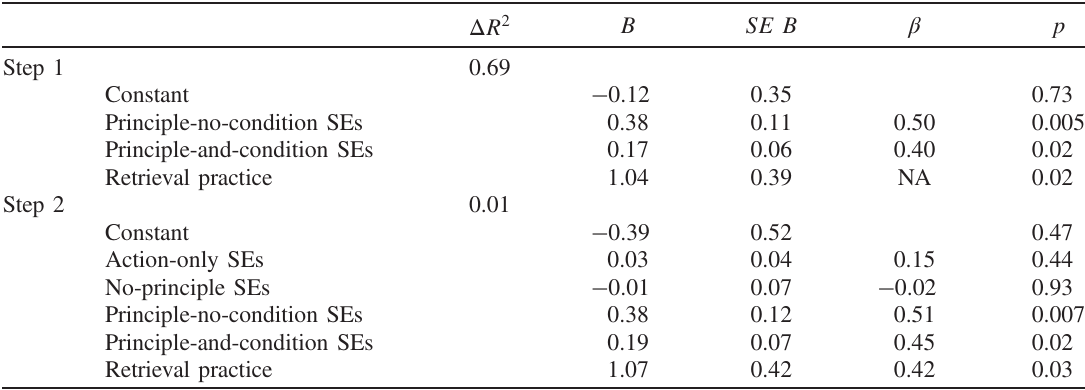
TABLE VI. Hierarchical regression of aggregated SE categories and retrieval practice as predictors of score on MBT items 5, 8, and 10. Note that n ¼ 18